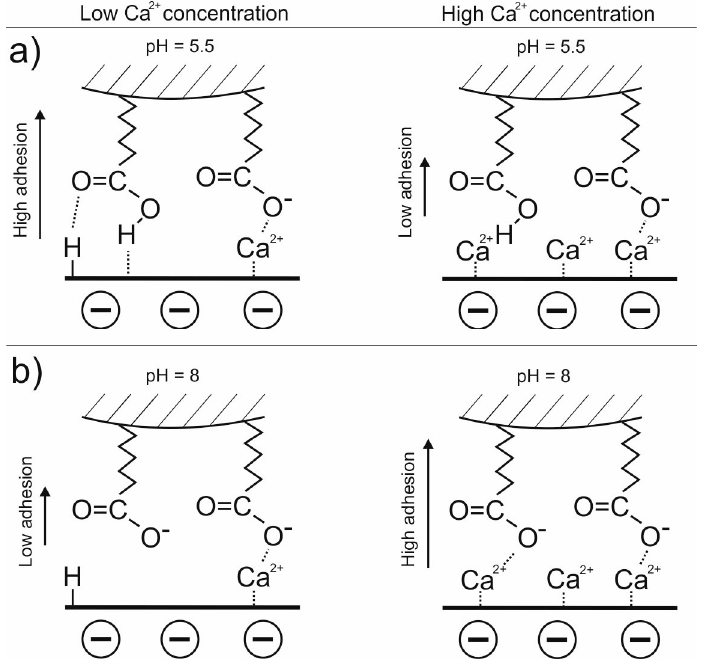
Figure 5. Idealized schematic cartoon showing the protonation state of the –COOH groups on the atomic force microscopy probe as well as complexation on the kaolinite siloxane surface at high and low concentrations of CaCl 2 and two pH conditions, ≈ 5.5 ( a ) and 8 ( b ).